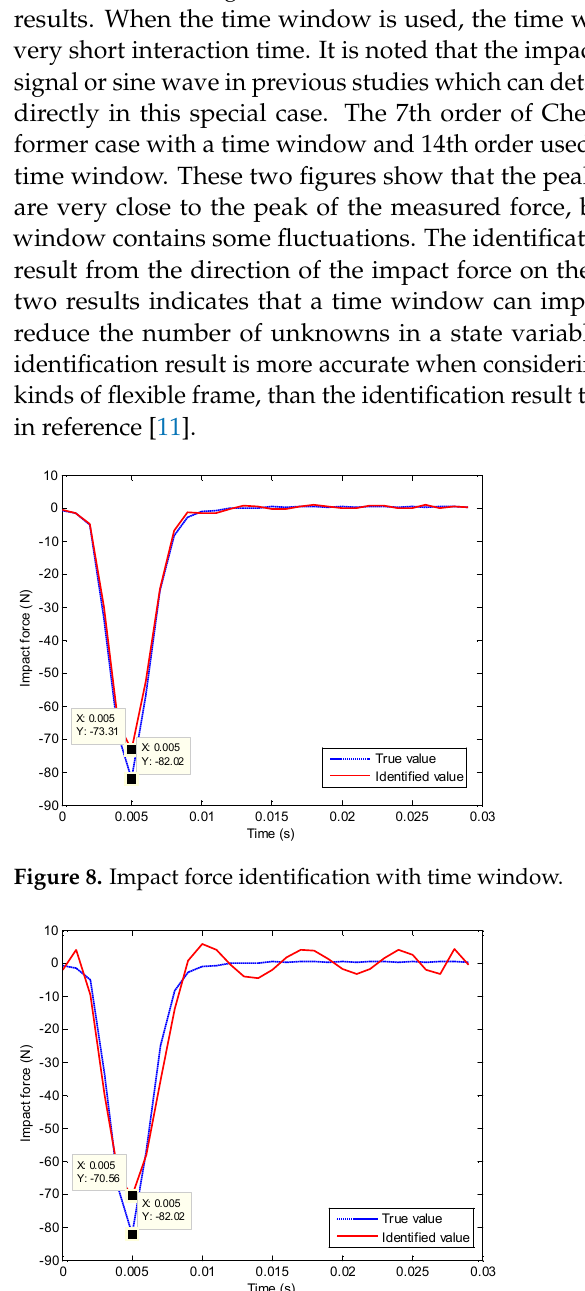
Figure 9. Impact force identification without time window.